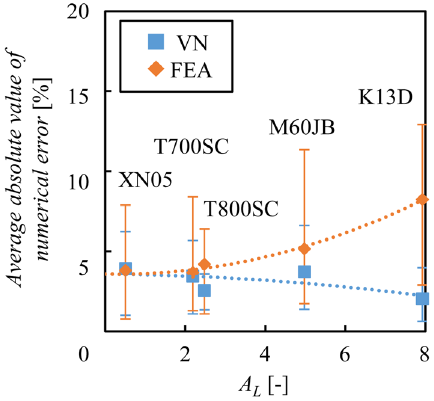
Fig. 13 The average absolute values of numerical errors as a func- tion of anisotropy index ( A L